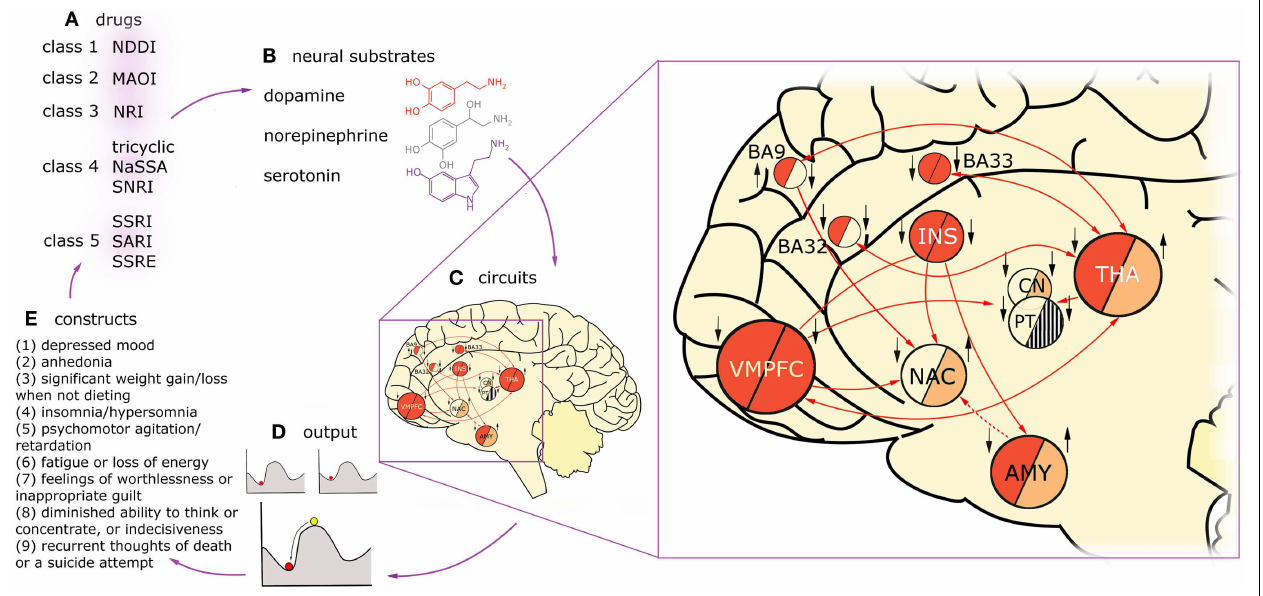
treatment in negative affect regime in MDD is indicated, on the right hand side: the same for positive affect regime. On one hand, this